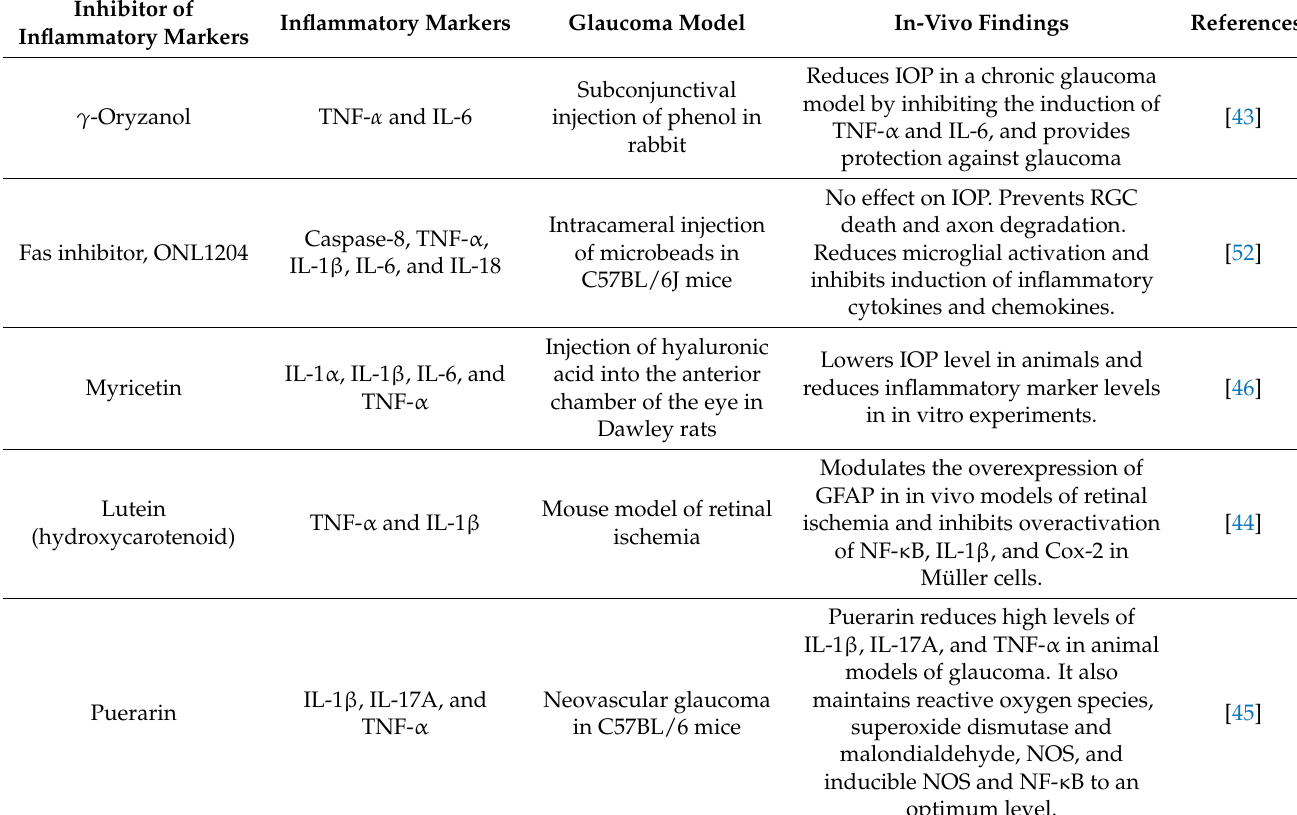
Table 1. Anti-inflammatory inhibitors tested in several in-vivo models of